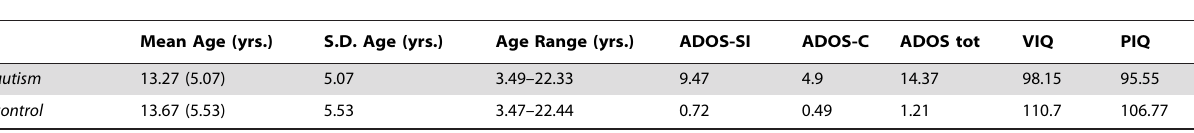
Table 1. Group demographics and neuropsychiatric test characteristics.